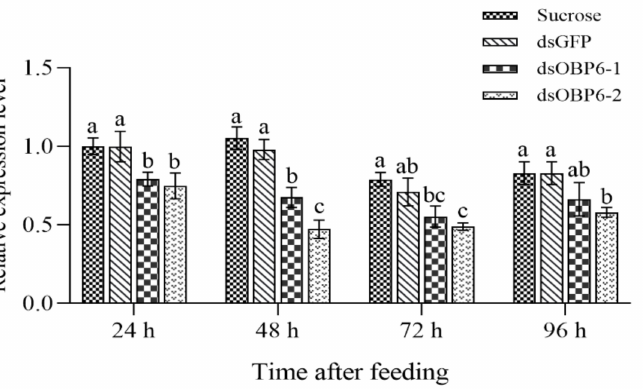
Figure 4. Silencing effect on the mRNA expression levels of AcerOBP6 after feeding worker bees at different times. The error bars represent the mean ± standard error, and means with different lowercase letters indicate significantly between 4 treatment groups of each time ( p <